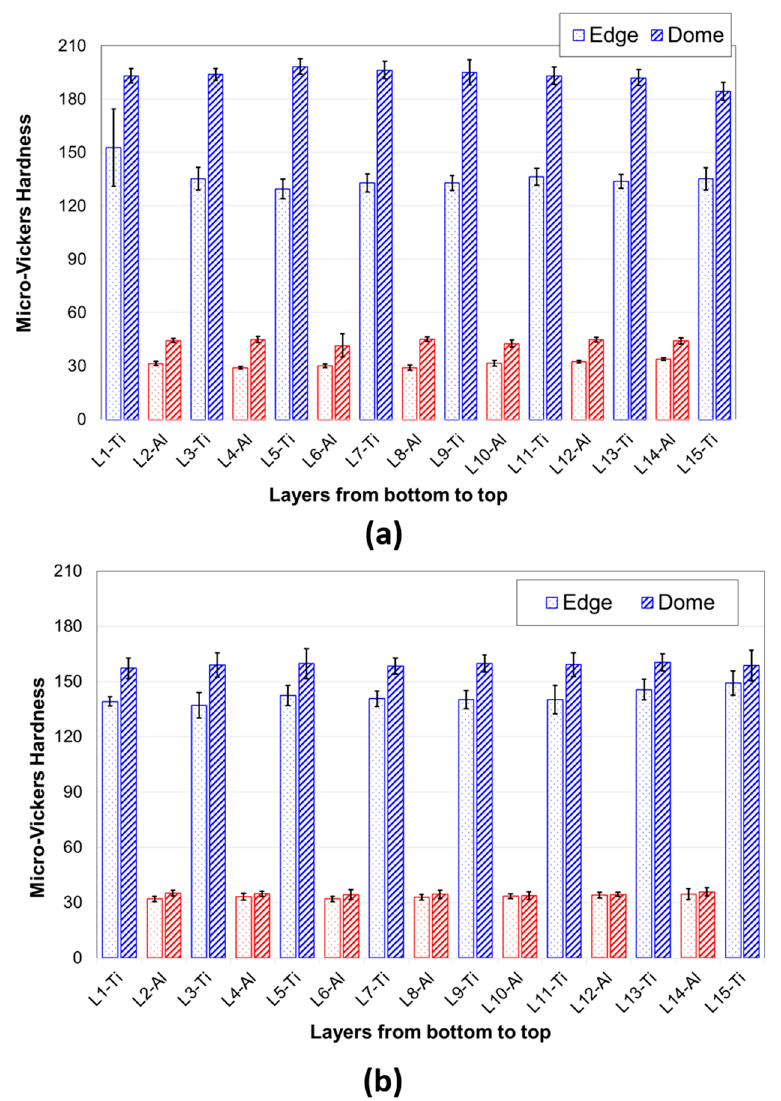
Figure 13. Micro-Vickers hardness values obtained at individual foils on edge and dome regions ( a ) for a bulged sample at RT and ( b ) for a bulged sample at 300 °C.